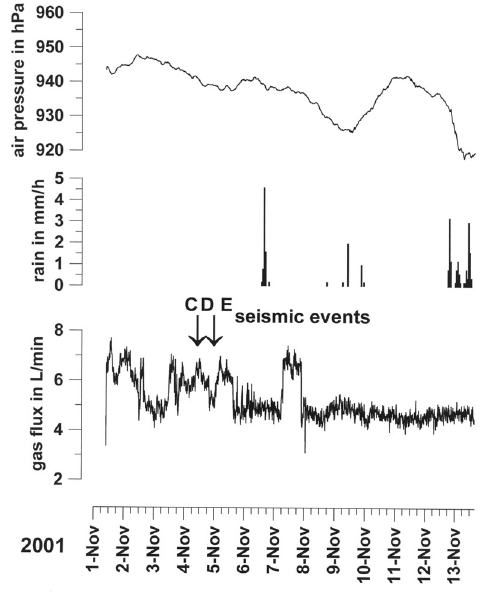
Fig. 4. Temporal variation of the gas flux and atmos- pheric pressure recorded at Tramutola station in the period from November 1 to 13, 2001. The capital let- ters C, D and E are local seismic events in that period. Their epicentres are presented in table I and fig. 2.